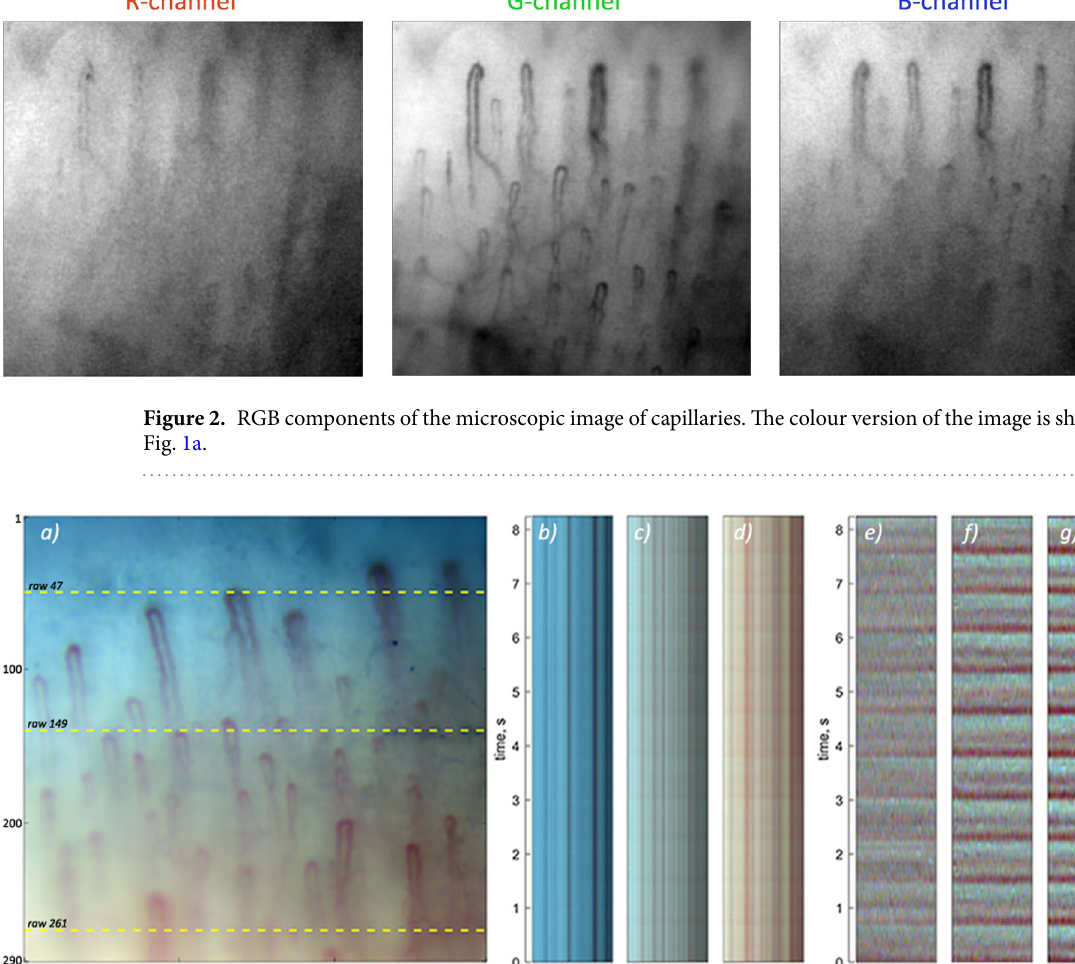
Dimension of recorded video capillaroscopy images is of 297 × 290 pixels. To analyse the light modulation in different parts of the images at the time scale of heartbeats, we constructed the diagrams in which any single row of pixels from the image frames recorded at different moments is arranged row-by-row in accordance with the current frame number during the time interval of video recording. The number of diagram rows is originated from the total number of recorded frames in the video. These diagrams are shown in Fig. 3b,c and d for the rows 47, 149, and 261, respectively. Row position is shown by dashed line in Fig. 3a. The diagrams in Fig. 3b–g demonstrate time evolution of remitted light intensity for each selected row of pix- els. Dark vertical lines are clearly seen in Fig. 3b–d. Position of each line in the horizontal axis corresponds to a respective capillary horizontal location (see Fig. 3a) with higher light absorption. Any change of the pixel value of a diagram along the vertical direction means its modulation in time. Actually, each diagram in Fig. 3b–d includes a small time-variable component caused by the heartbeats. While the diagram in Fig. 3b (row 47, which is situated near the nail) is almost uniform in time, shiny horizontal areas, which are visible in Fig. 3c and d (rows 149 and 261) under careful observation, suggest occurrence of periodical light intensity modulation. This modulation is poor visible in the figures. To make this modulation more evident, we subtracted a slowly varying component along vertical direction in a diagram separately from each pixel time-variable value thus enhancing an alternating component (AC) of light modulation, which is varying at the heartbeat or higher rate. This modulation at the same rows (47, 149, and 261) is represented in Fig. 3e–g. Darker horizontal areas are clearly seen in Fig. 3e–g demonstrating modulation of the remitted light with peri- odicity of about 0.75 s almost uniform along an image row. We will show in the next Section that this modulation well correlates with both the electrocardiogram and RBC speed. Horizontal orientation of the dark lines in the diagrams means synchronous modulation of the pixel values for all pixels in a row. Moreover, these lines appear